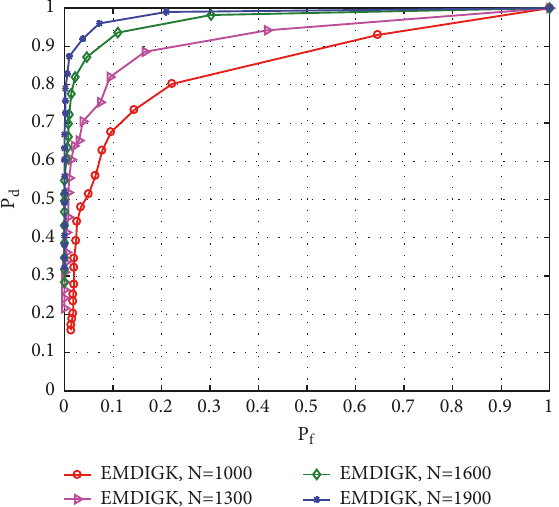
Figure 9: The ROC curve with different numbers of sampling points 𝑆𝑁𝑅 = −16 dB.